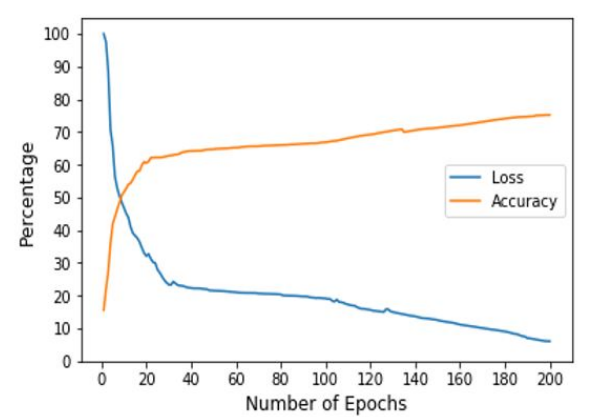
Figure 8. Graph showing loss (MSE)/accuracy vs. number of epochs (Dataset: 1.2 K, Batch Size: 20, number of Epochs = 200, Optimizer: Adam, loss = 6.08%, model accuracy = 75.23%).